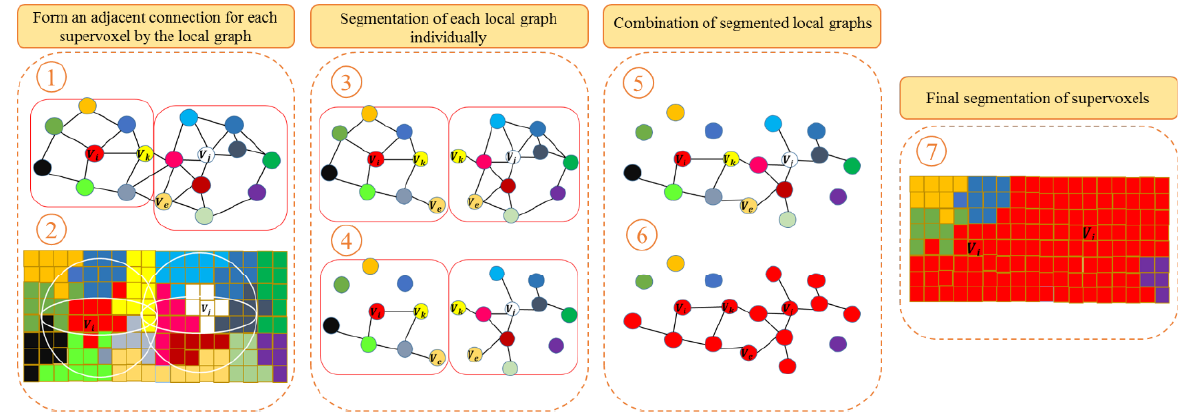
Figure 3 . The general steps of the segmentation method based on local graphs (Xu et al., 2017).